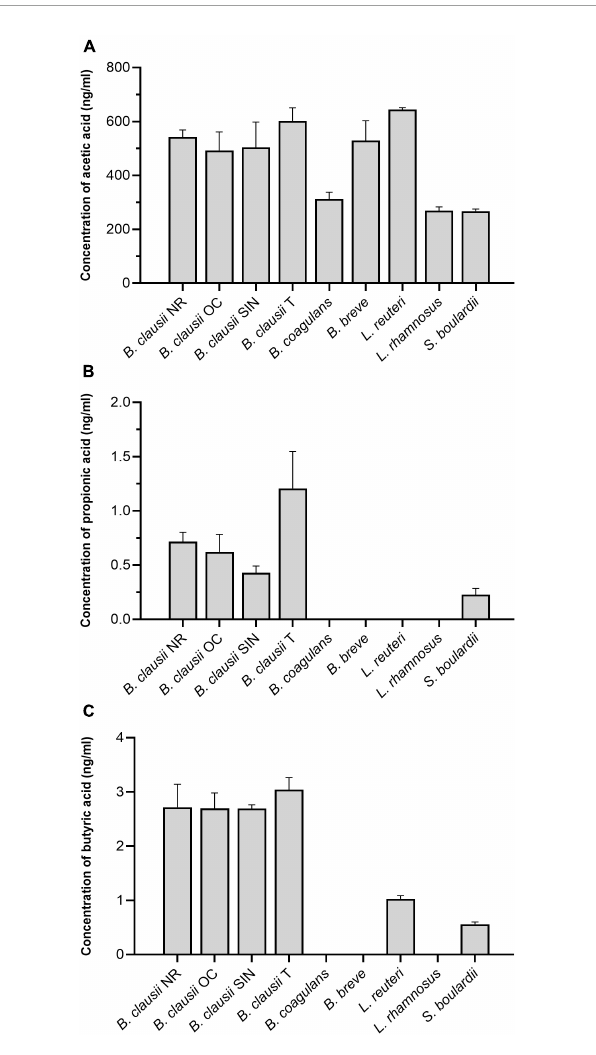
FIGURE2 (A) Concentration of acetic acid (ng/mL) in the culture supernatants of B. clausii (NR, OC, SIN, and T) , B. coagulans , B. breve , L. reuteri , L. rhamnosus , and S. boulardii . NR = B. clausii NR; OC = B. clausii OC; SIN = B. clausii SIN; T = B. clausii T; BC = B. coagulans